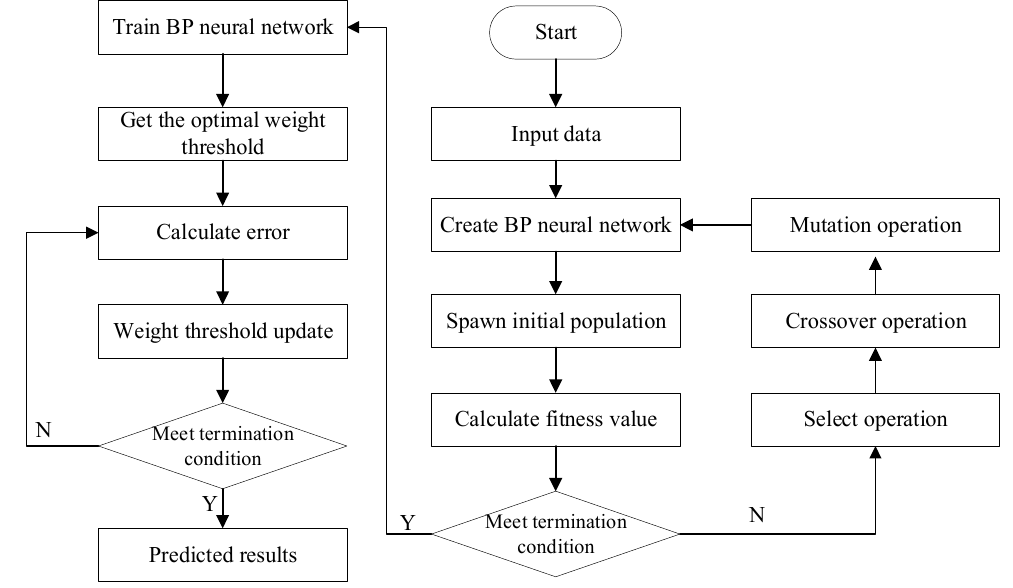
Figure 2. Flow chart of genetic algorithm optimized backpropagation neural network (GA-BPNN).